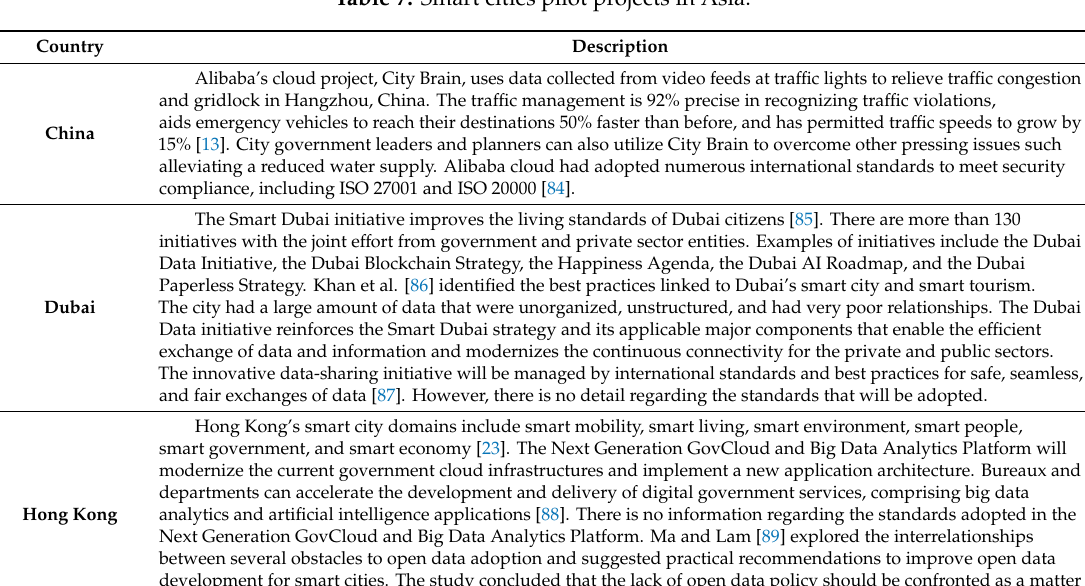
Table 7. Smart cities pilot projects in